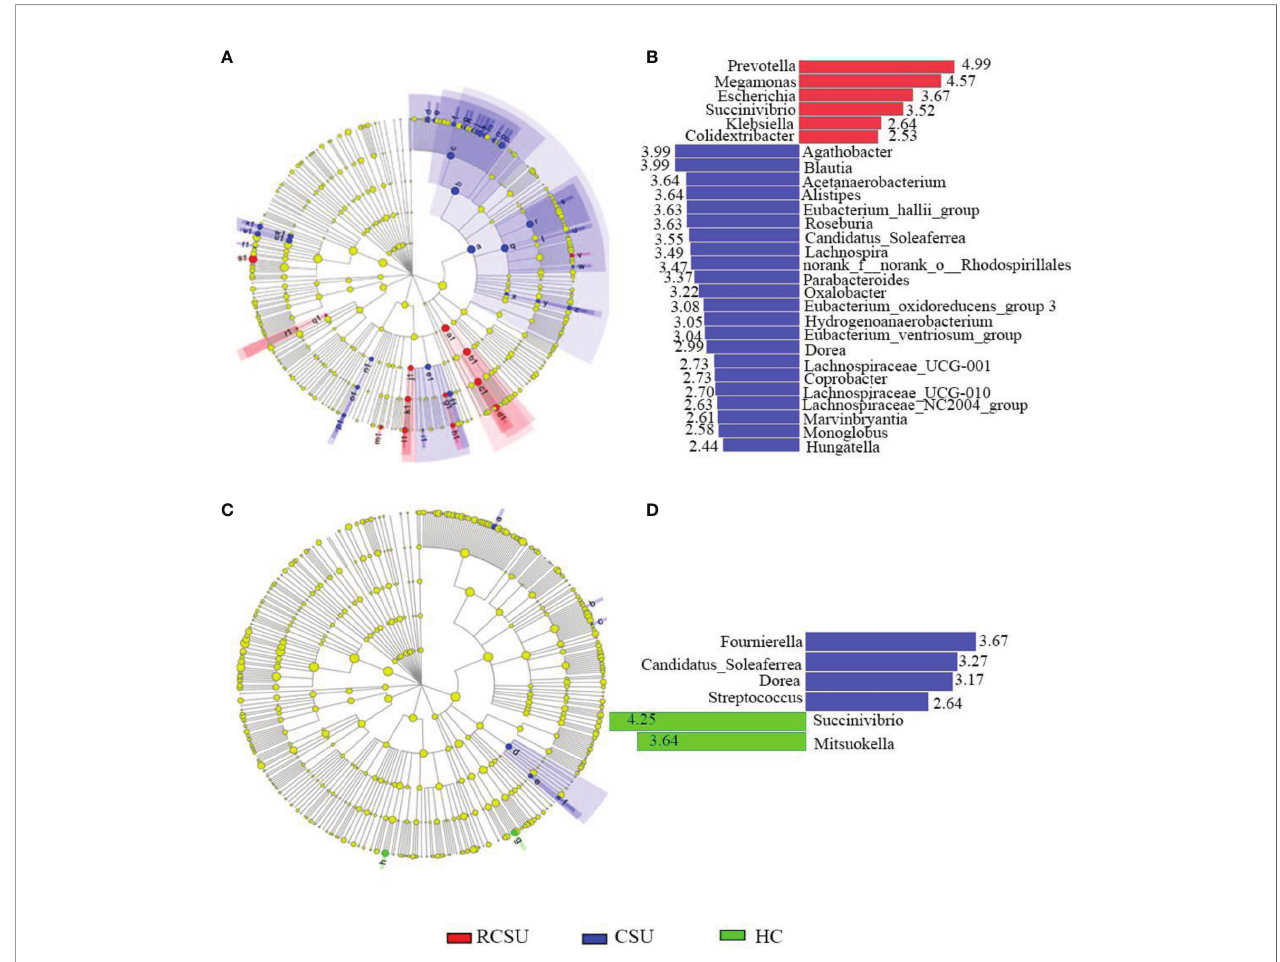
FIGURE 4 | Differently abundant taxa identi fi ed using LEfSe analysis among groups. Distribution of differently abundant taxa from phylum to genera levels between the RCSU and the CSU groups (A) and between the CSU and the HC groups (C) . LDA showing the impact of different species on the difference between the RCSU and the CSU groups (B) , and between the CSU and the HC groups (D) , and visualization of only taxa meeting an LDA ≥